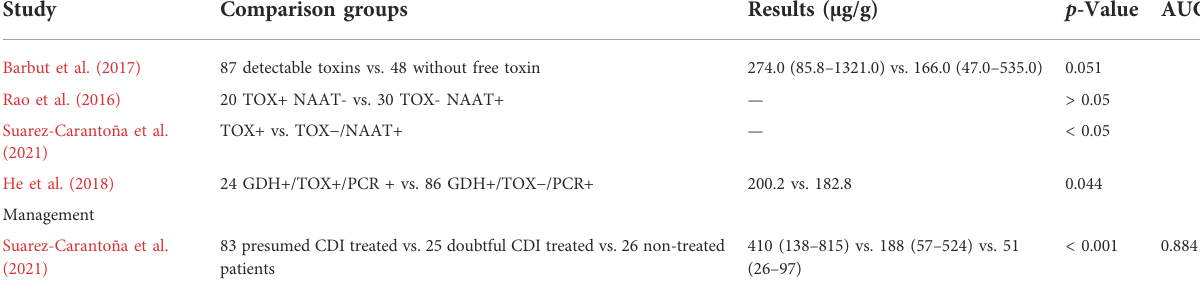
TABLE 7 Main results of fCP in other aspects of